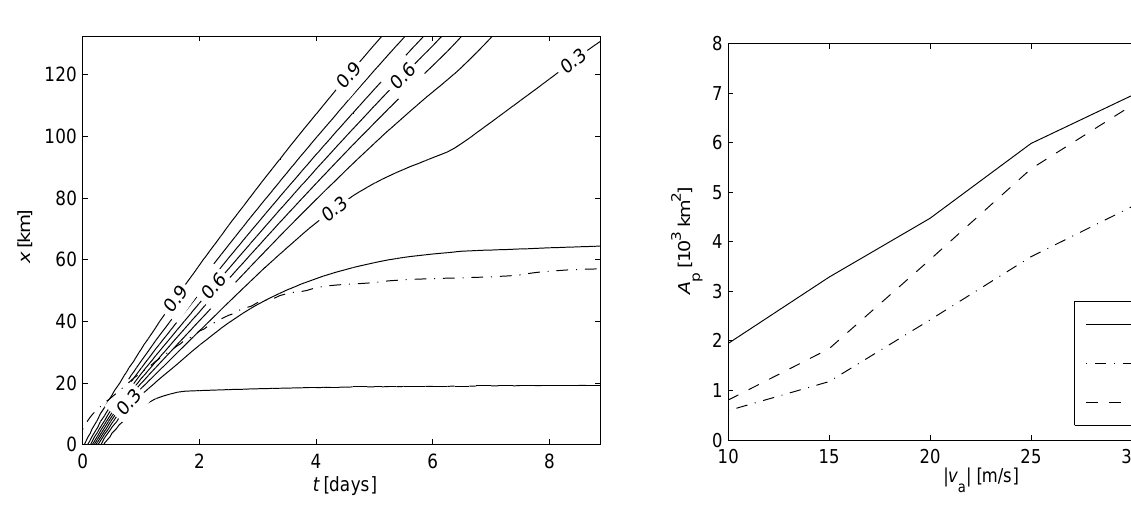
Fig. 11. A Hovm¨oller diagram of the ice thickness field ( h ) us- ing the new-ice thickness formulation by Mellor and Kantha (1989) taken along a section at y =37.5km. The vertical axis ( x ) is the along channel distance and the horizontal axis ( t ) is the model time. The dash-dotted line shows the isoline for A =0.8 from the control run.